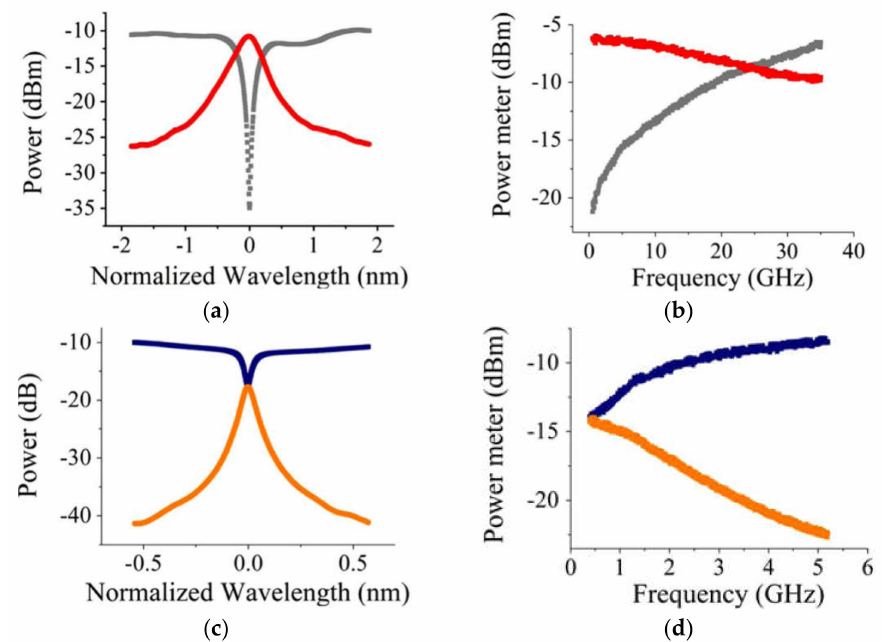
Figure 18. Measured transmission spectra and output power from the through and drop ports of the ring: ( a , b ) for a 0.5–35 GHz frequency range IFM system; ( c , d ) for a 0.1–5 GHz frequency range IFM system (Adapted with permission from Ref [32]. Copyright 2017, Elsevier).